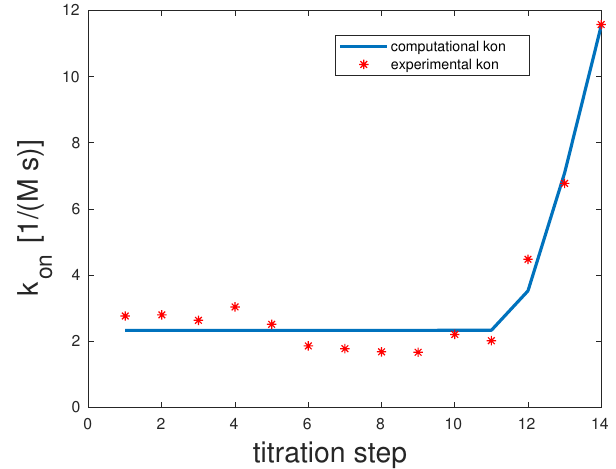
Figure 4. Comparison of the computed and experimental [14] k on rates for pentavalent Man(1,3,5,7,9)S-9; see the Supplementary Information (SI) for additional information on experimental data. The k on rates were 1, 1, 10,000, and 10 and for k off were 10,000, 1, 1, and